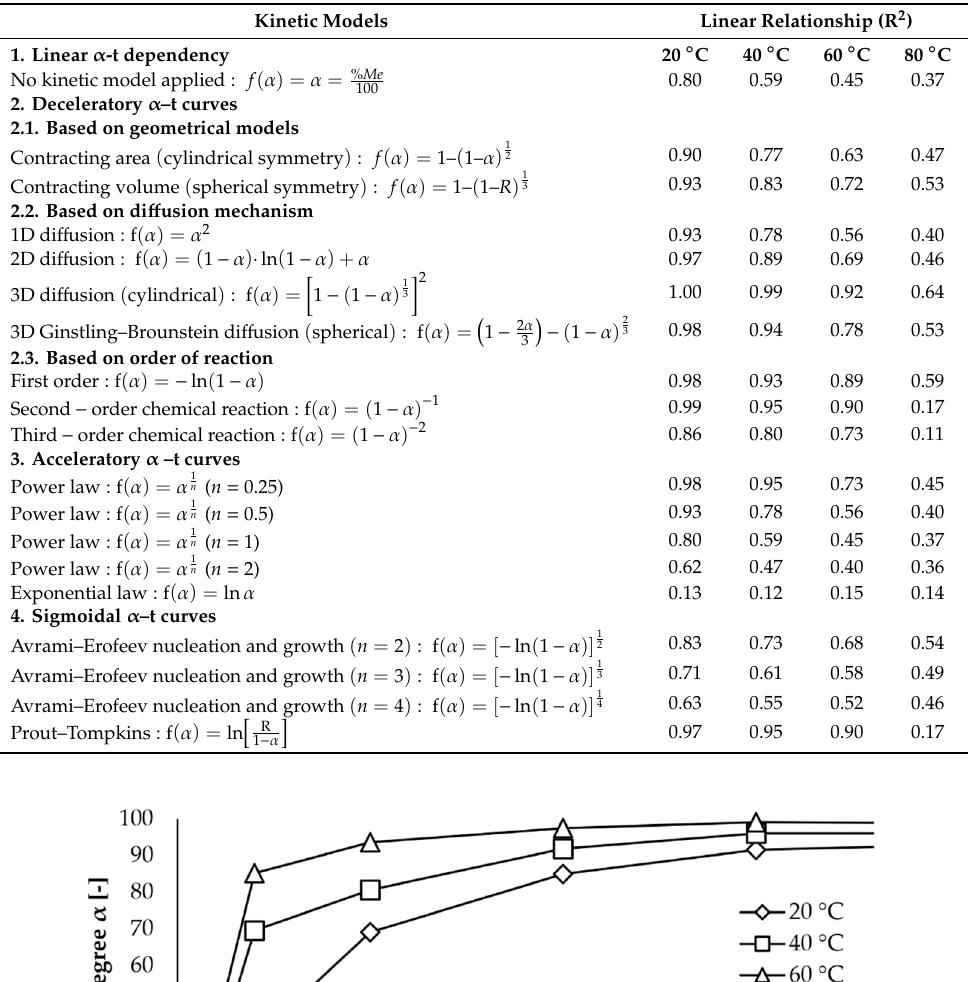
Table 4. Kinetics models and linear relationship of model functions over time represented by coe ffi cient of determination (R 2 ) value, kinetic models from [39].